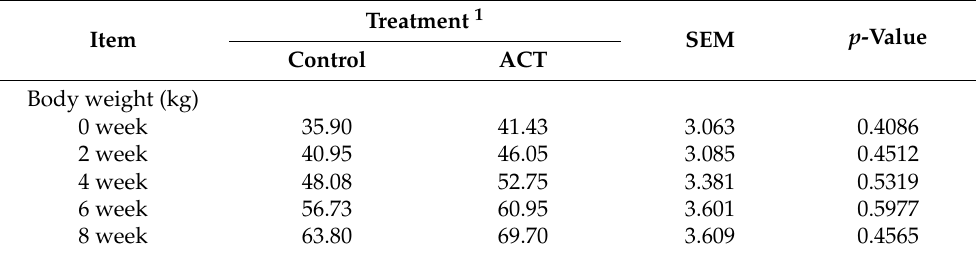
Table 3. Weight of calves birthed by dry cows fed basal diet (control) and diet containing ACT for 8